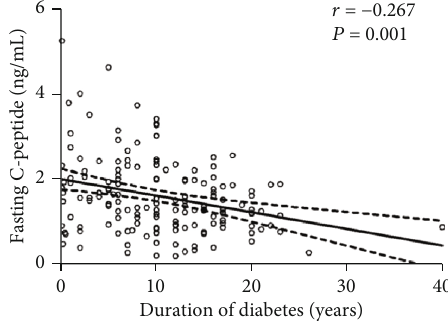
Figure 3: Correlation of duration of diabetes with fasting C-peptide